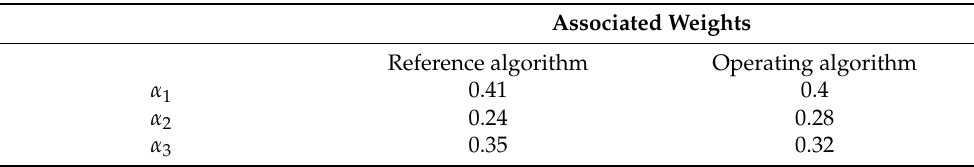
Table 5. Estimation of the weights based on the survey answers.